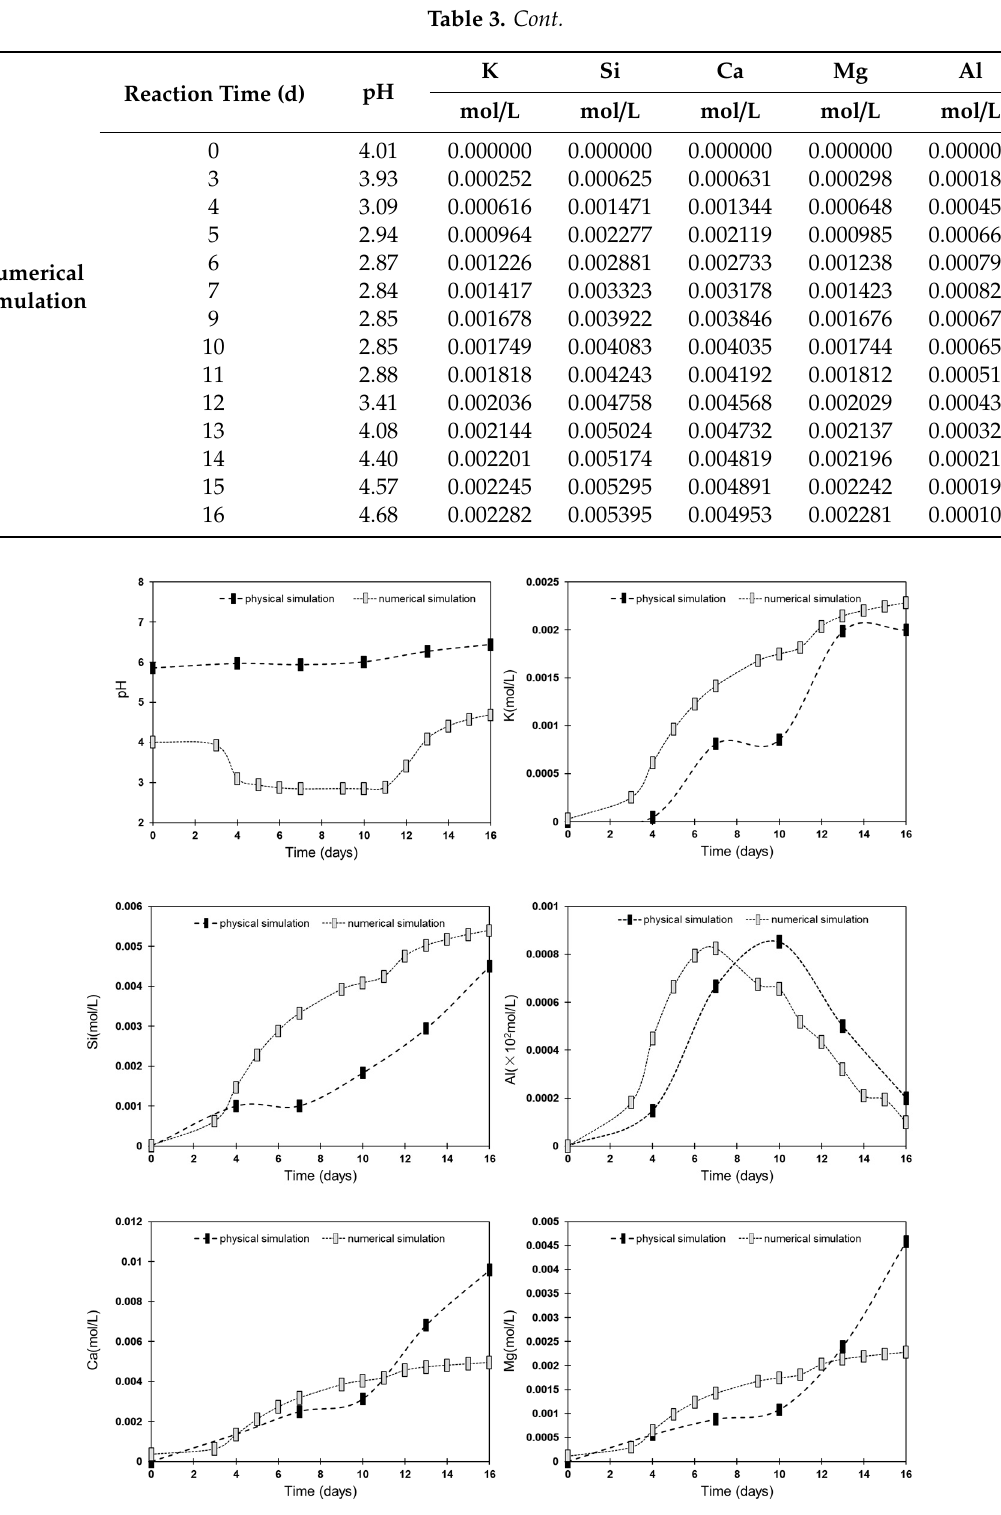
Figure 4. Changes of pH and typical ion concentrations over the physical and numerical simulations.